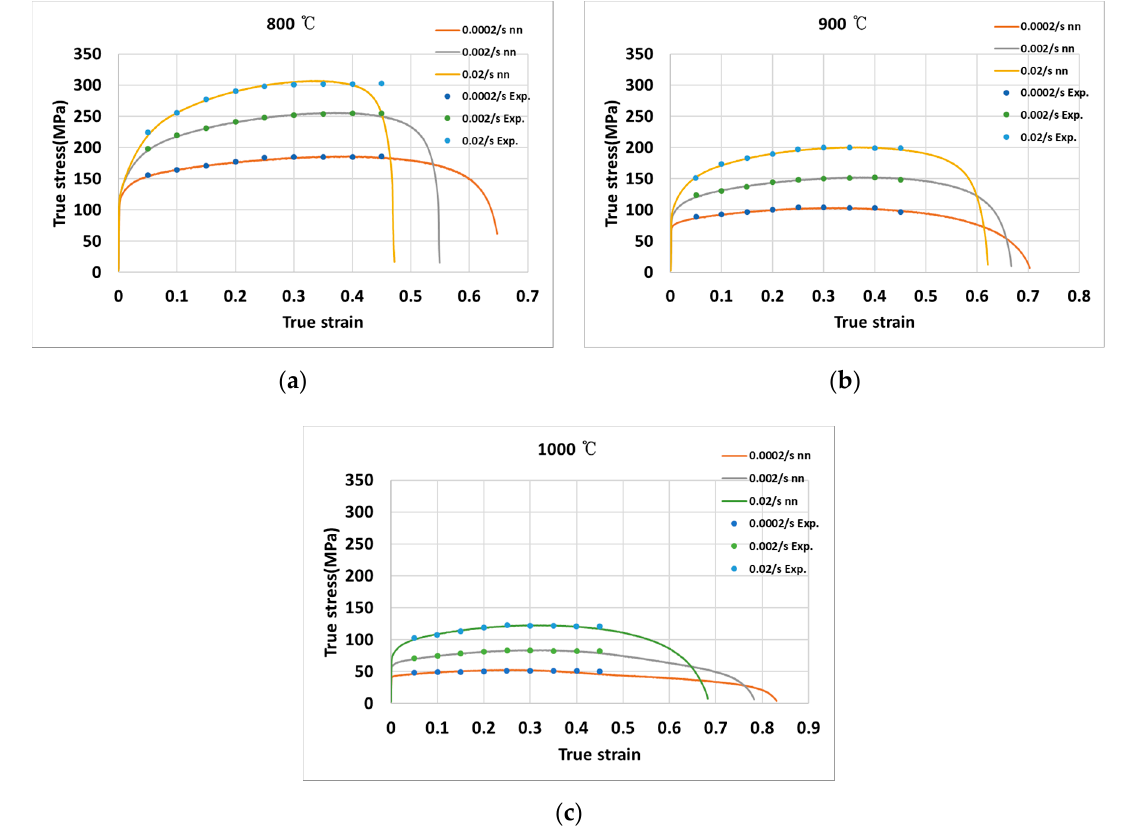
Figure 9. True stress-true strain curves at ( a ) 800 °C; ( b ) 900 °C; ( c ) 1000 °C.